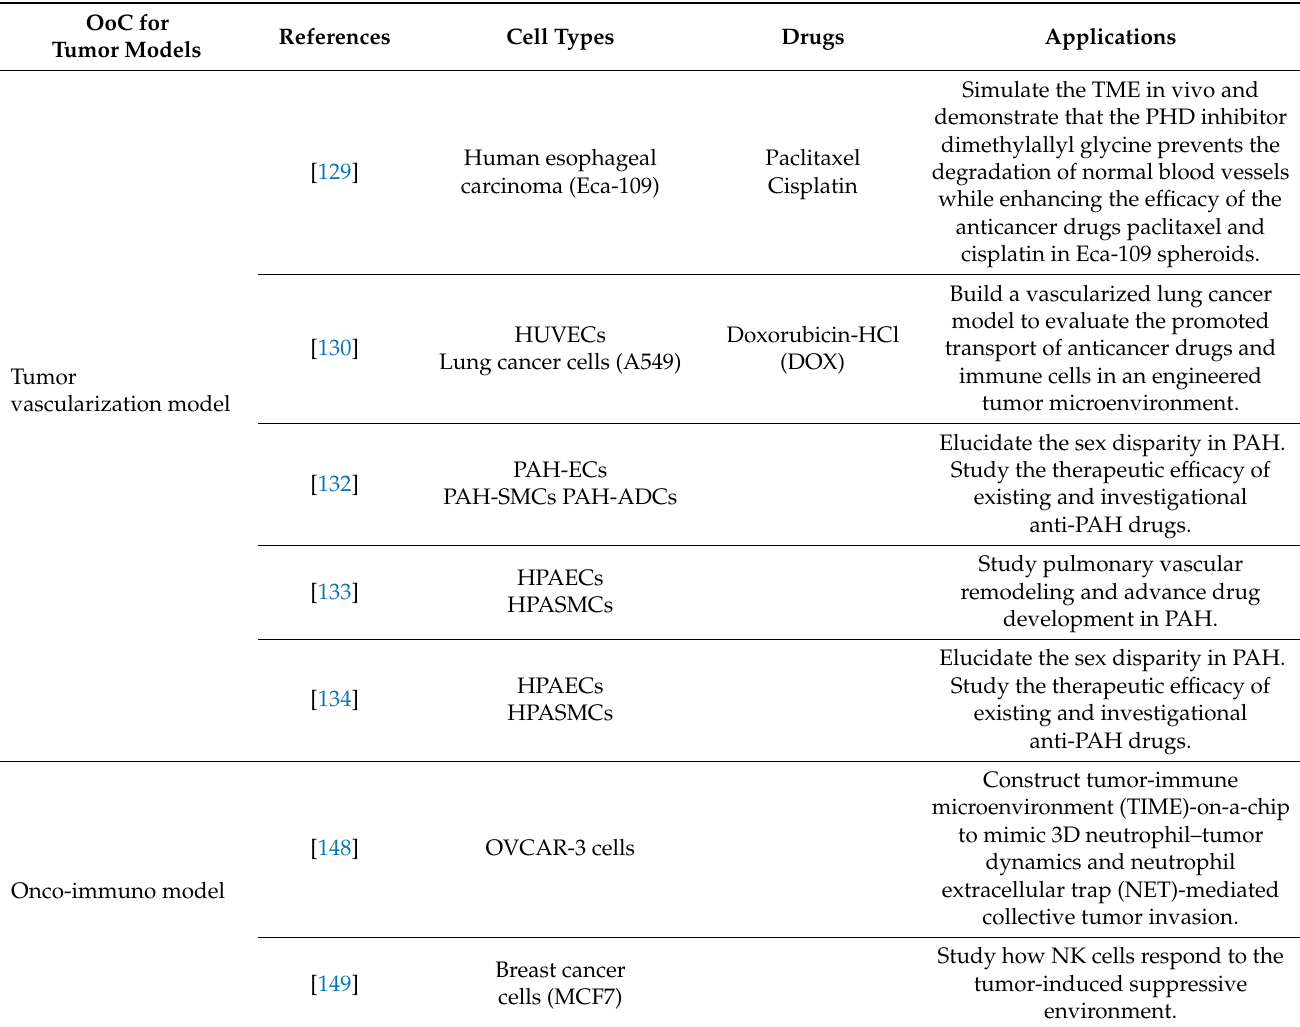
Table 5. Summary of the different types of OoC for tumor